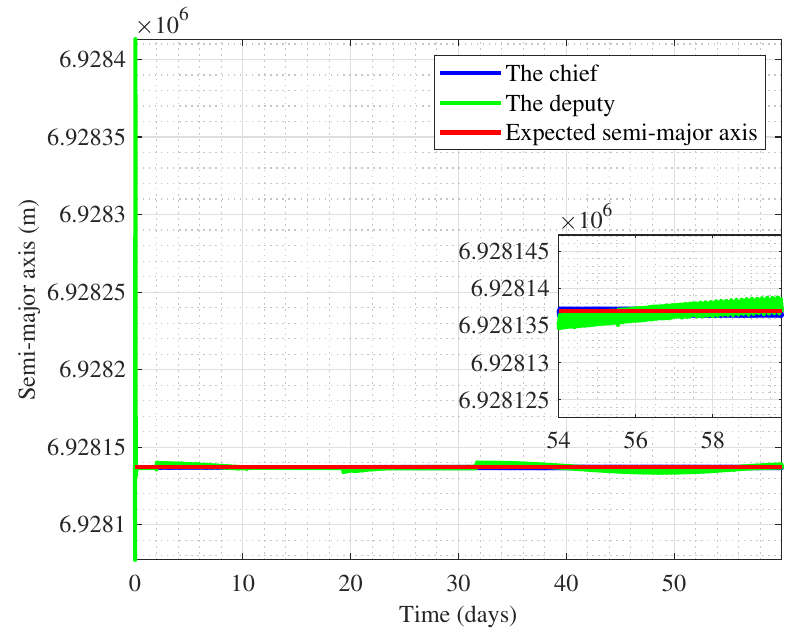
Figure 9. Semi-major axis time histories under semi-major axis